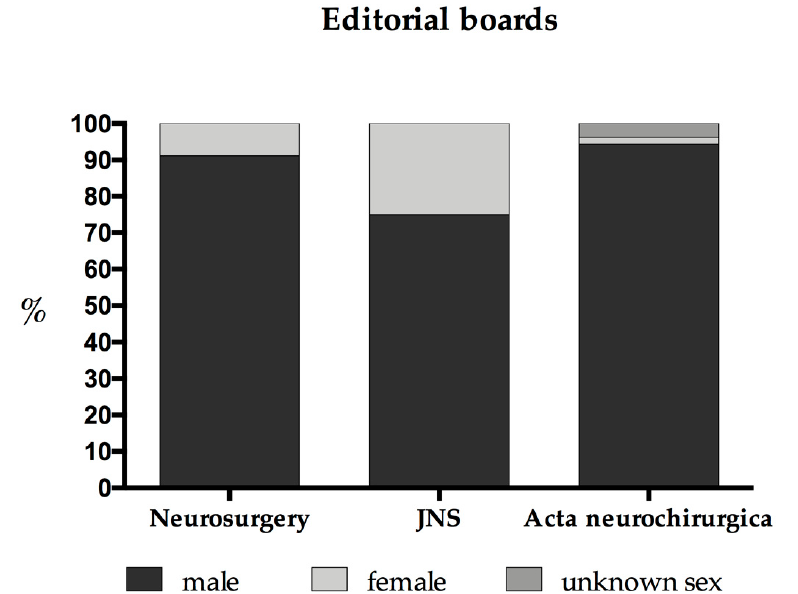
Figure 4. Composition of editorial